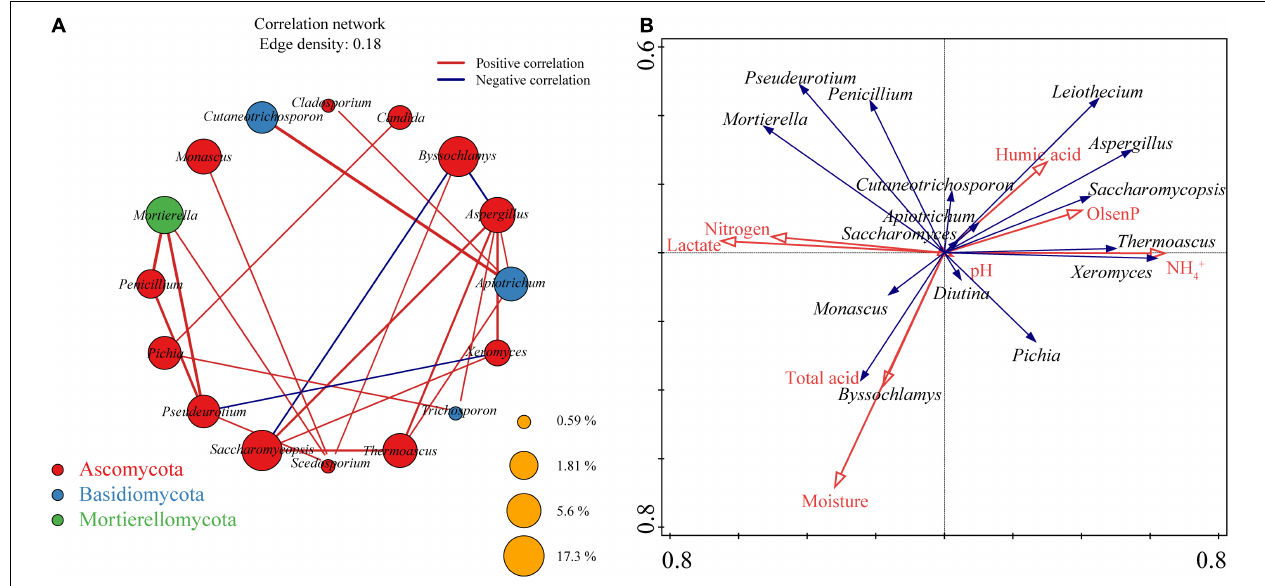
FIGURE 6 | Co-occurrence network depicting the interactions between fungal communities (A) . RDA biplot showing the relationship between the dominant fungal genera and physicochemical factors (B)